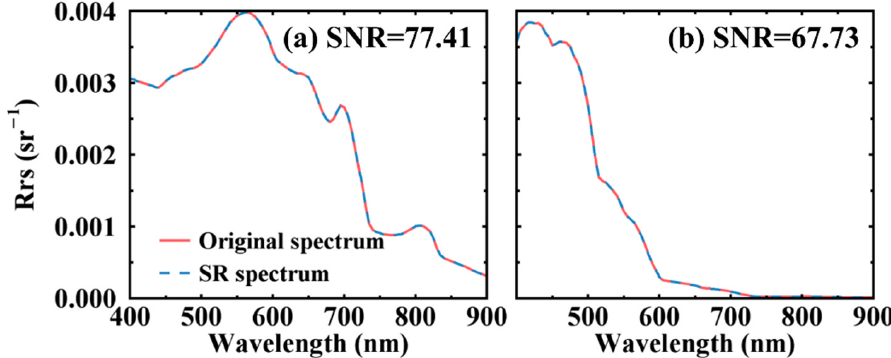
Figure 4. Two representative spectra and their corresponding SR spectra. The SNR indices are 77.41 ( a ) and 67.73 ( b ), respectively.